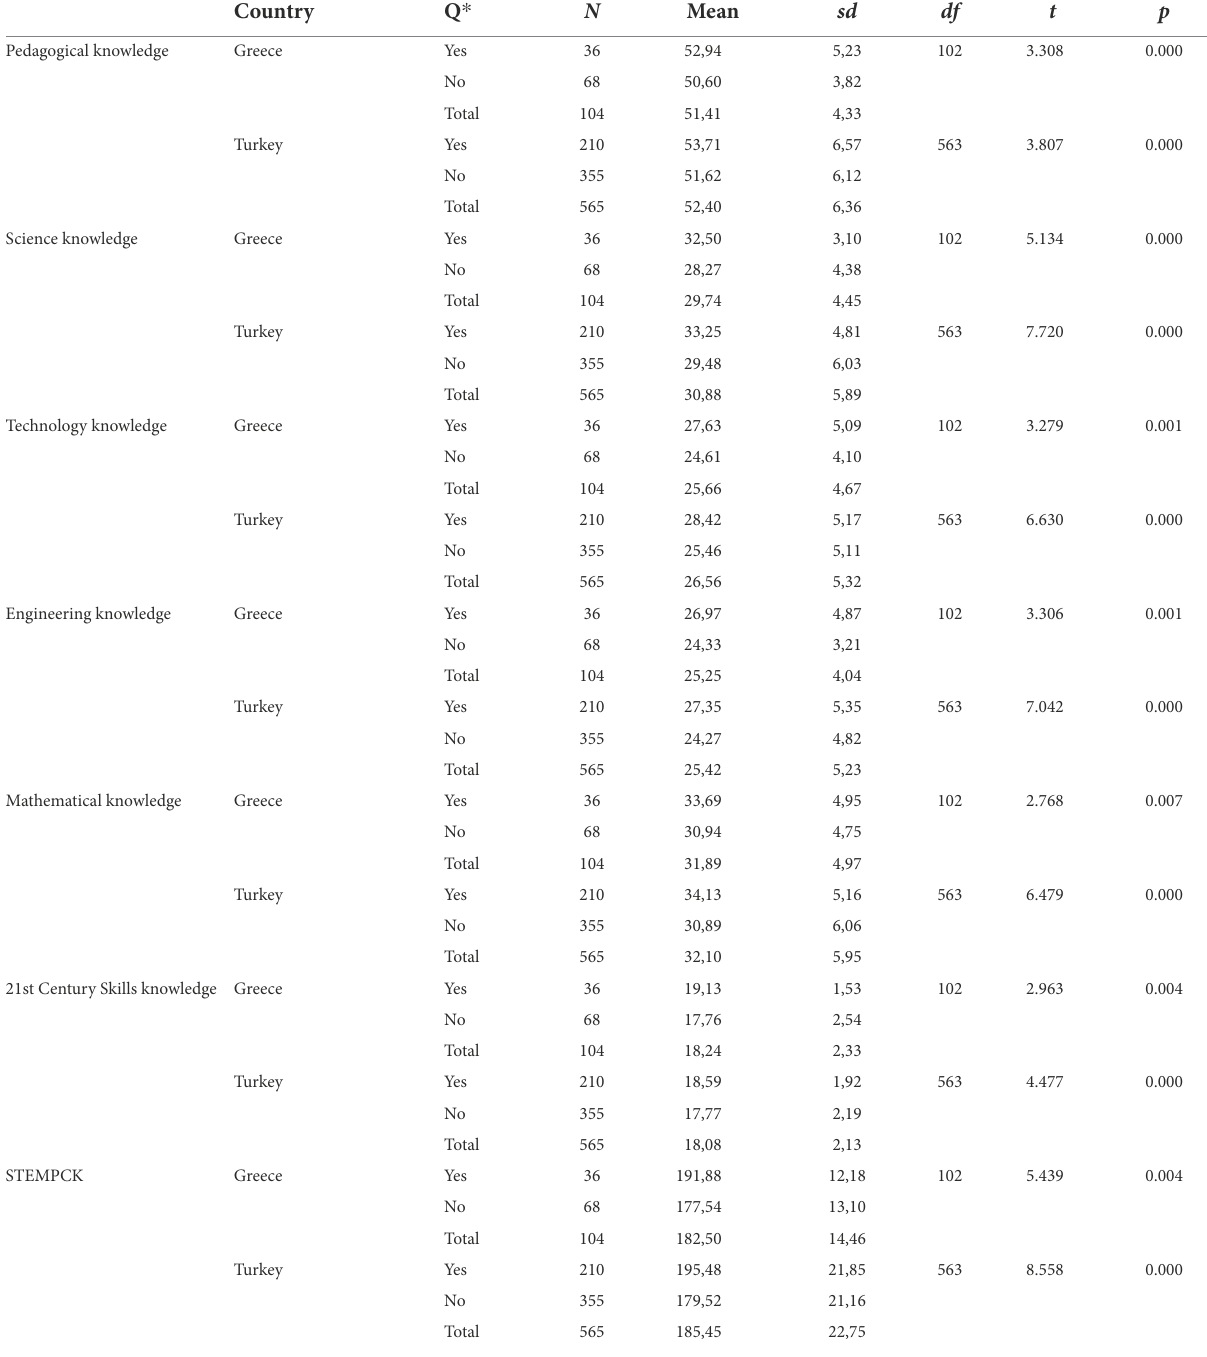
TABLE 7 Independent t -test result of STEM education status by country.